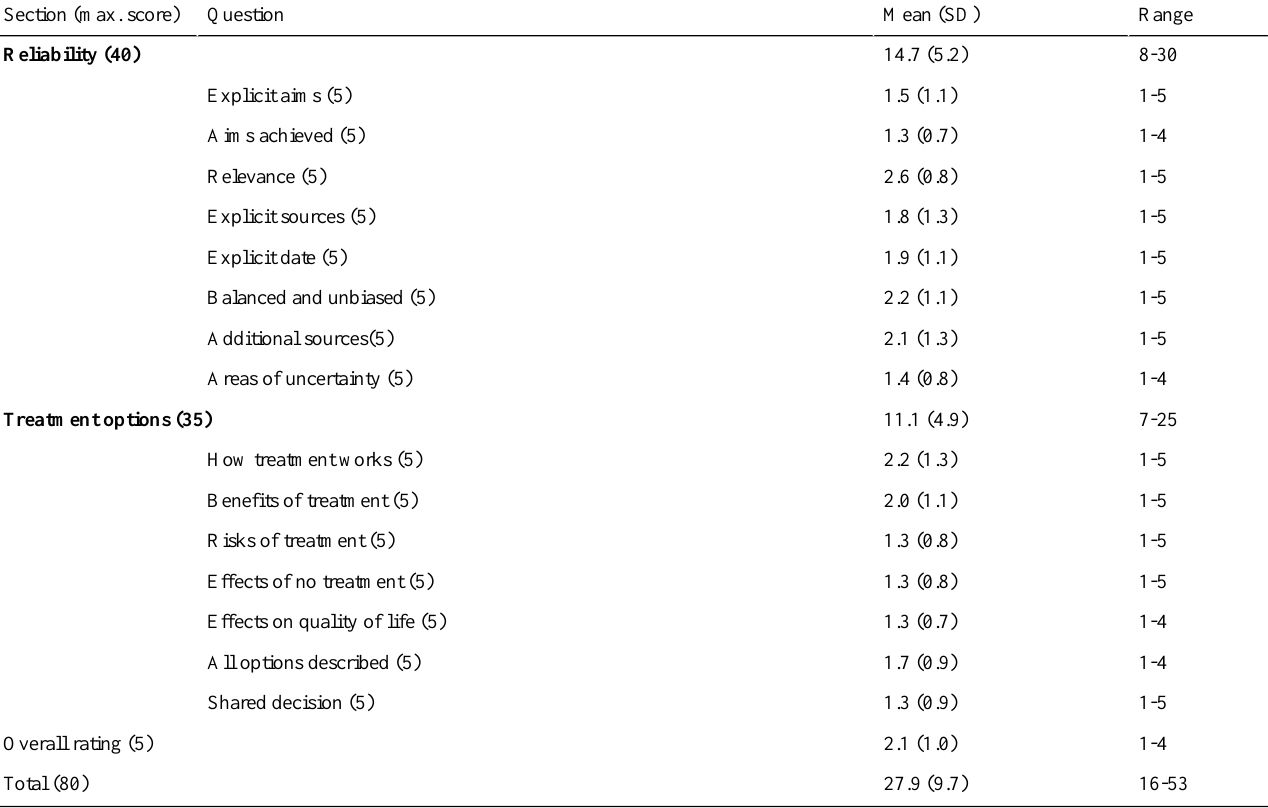
Table 2. Means, standard deviations (SD), and ranges of the included websites (N=67) measured by the DISCERN instrument (the maximum achievable scores in shown in brackets after each section and question).